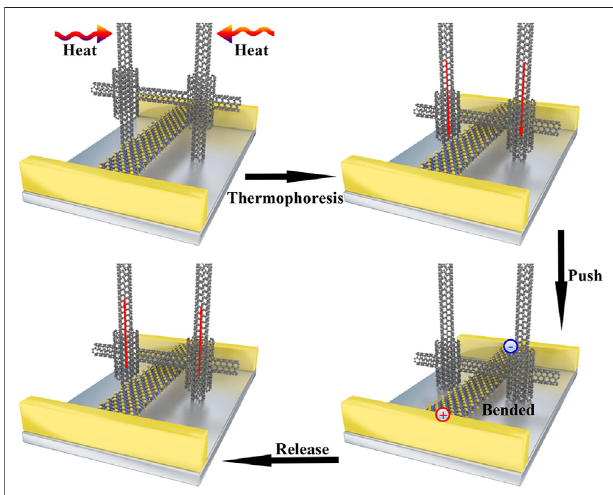
FIGURE 1 | Sketch of the thermoelectric conversion process driven by thermophoresis and piezoelectric effects. The concentric carbon nanotube is made of an [4, 4] inner tube and [8, 8] outer tube with the length of 36.9 and 3.3 nm, respectively. An armchair edge MoS 2 nanoribbon with the lengthof21.9 nmisadopted,andthedifferentwidthsofthenanoribbon(1.58, 2.21, and 2.84 nm) are investigated for